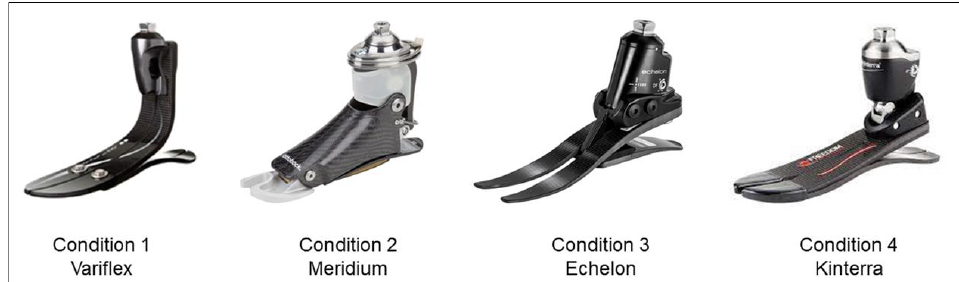
Figure 1. The four tested prostheses. Variflex LP (Össur, Reykjavik, Iceland): ESR prosthesis with a carbon foot. Meridium (Ottobock, Duderstadt, Germany): a microprocessor-controlled prosthetic that automatically adjusts to different types of walking, changes in inclination and different walking speeds. Echelon VT (Chas. A Blatchford & Sons, Basingstoke, UK): A dynamic carbon fiber foot comprising independent toe and heel springs with a hydraulic self-aligning ankle. Kinterra (Freedom Innovations, Morgan, CA, USA): A hydraulic articulation combined with an energy-storage-and-return foot. The specificity of each prosthesis is detailed in Table S1.